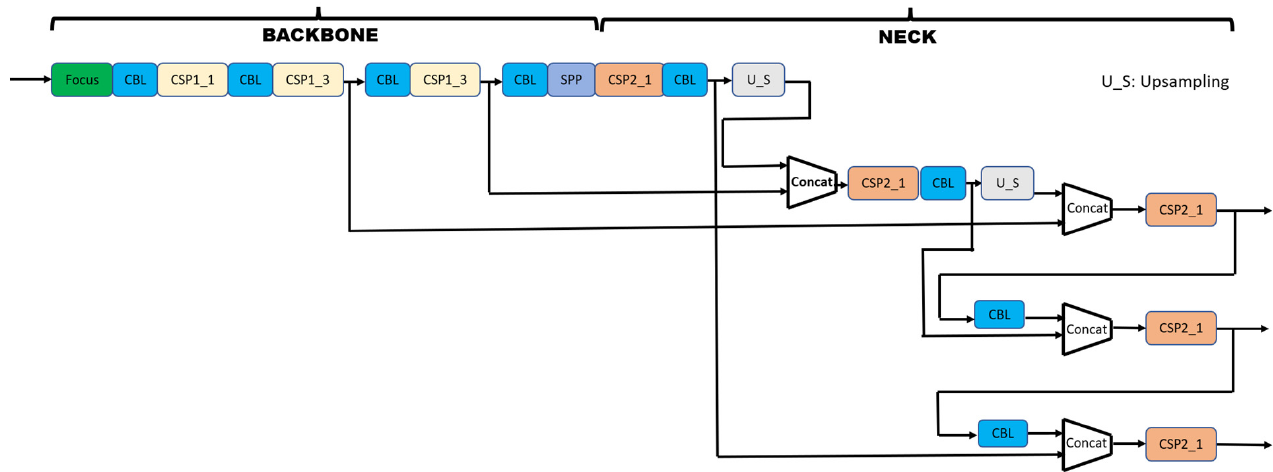
Figure 5. CSP structure for YOLOv5 model [39].